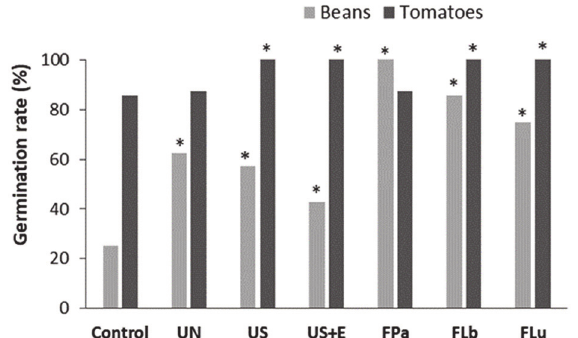
Figure 1. Effect of the rice bran (RB) additives to PGS on germination rate of bean and tomato seeds. Control, PGS; UN, untreated RB; US, ultrasonicated RB; US+E, ultrasonicated and enzyme-hydrolyzed RB; F Pa , F Lb , F Lu , RB fermented with appropriate lactic acid bacteria strain. * significant at p < 0.05 compared to the controls.